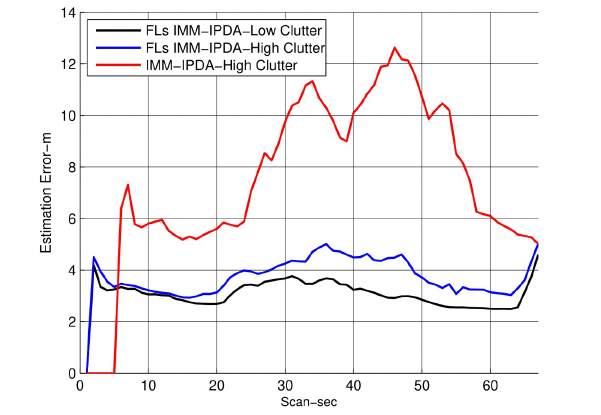
Figure 9. Root mean square error performance for clutter density: 2 × 10 − 4 m − 2